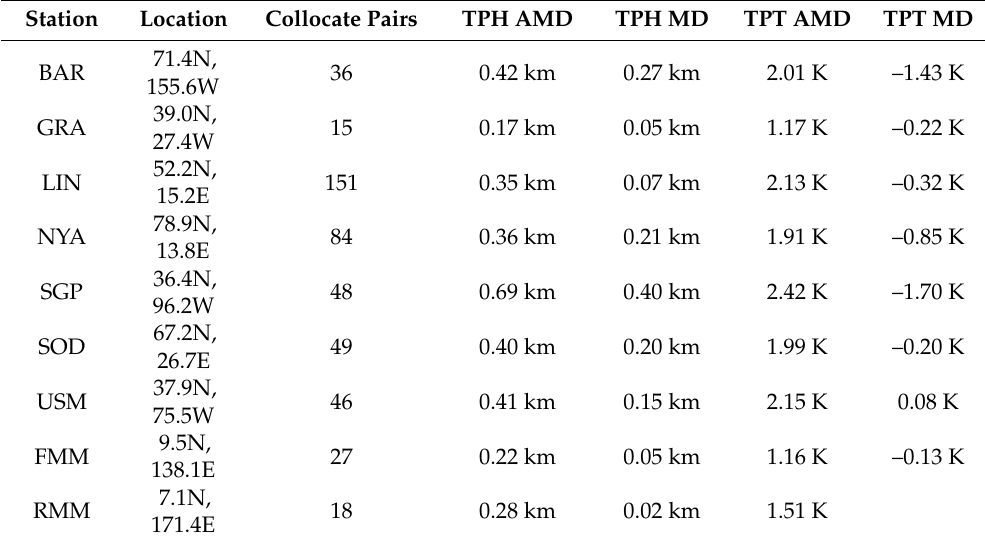
Table 2. The statistical comparison results of FY-3C and radiosonde data of nine